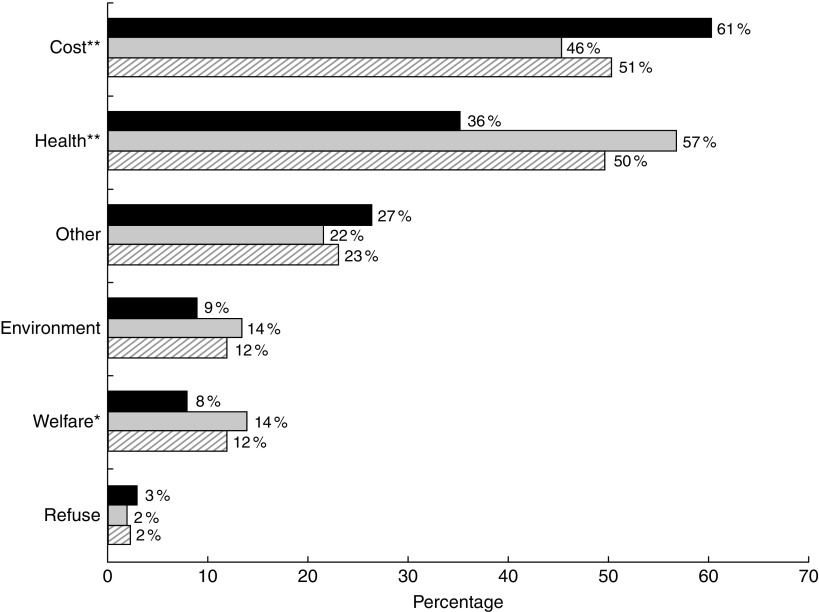
Reasons for meat reduction by income (, <$US 40 000; , ≥$US 40 000; , overall) in a nationally representative adult sample: USA, 2015. Figure depicts the stratified results for percentage indicating each item was a reason for meat reduction, by income. P values reflect χ2 for cross-tabulation: *P<0·05, **P<0·01, ***P<0·001